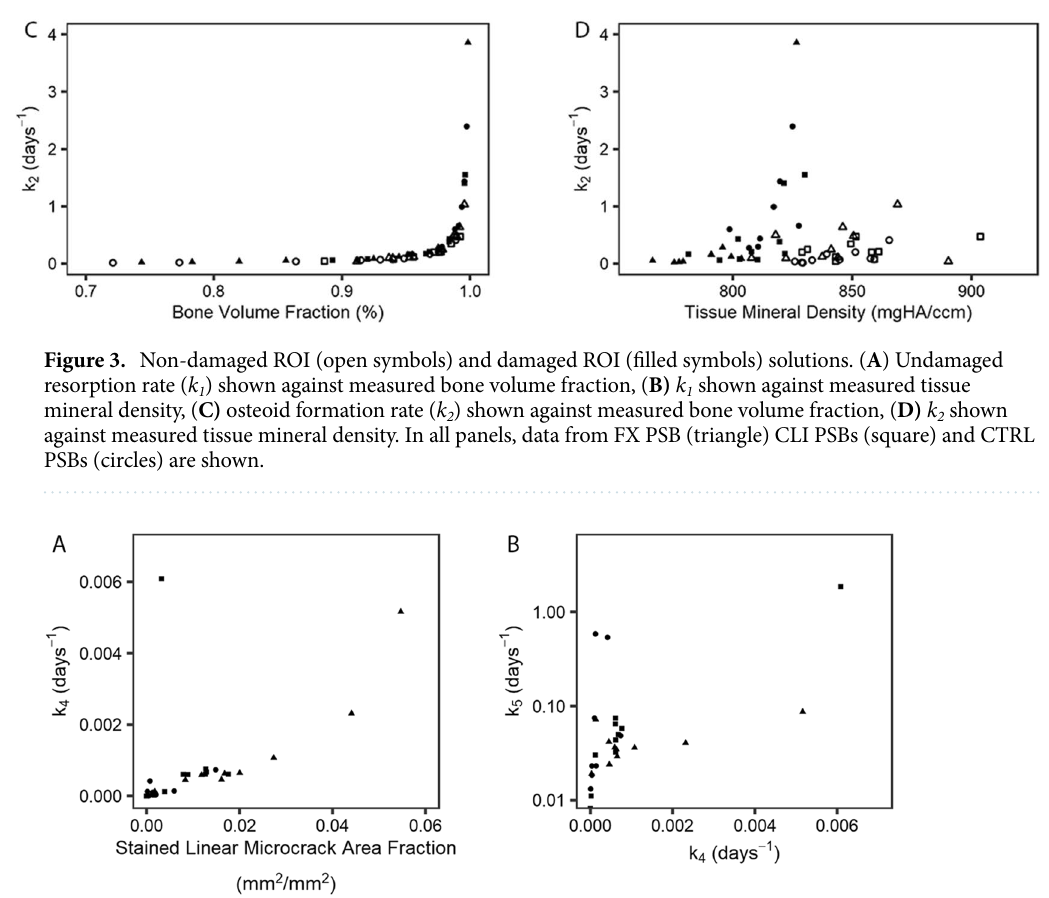
Figure 4. Damaged ROI solutions for the damage formation rate ( k 4 ) and damage resorption rate ( k 5 ) shown for the FX PSBs (triangle), CLI PSBs (square) and CTRL PSBs (circle). ( A) k 4 plotted against the stained microcrack area fraction (Cr.Af); note, in the model, BV D / TV ≡ Cr.Af. ( B) k 4 plotted against k 5 . In both panels, solutions for the non-damaged ROI are not shown, as Cr.Af, k 4 , and k 5 were zero in the non-damaged ROI.